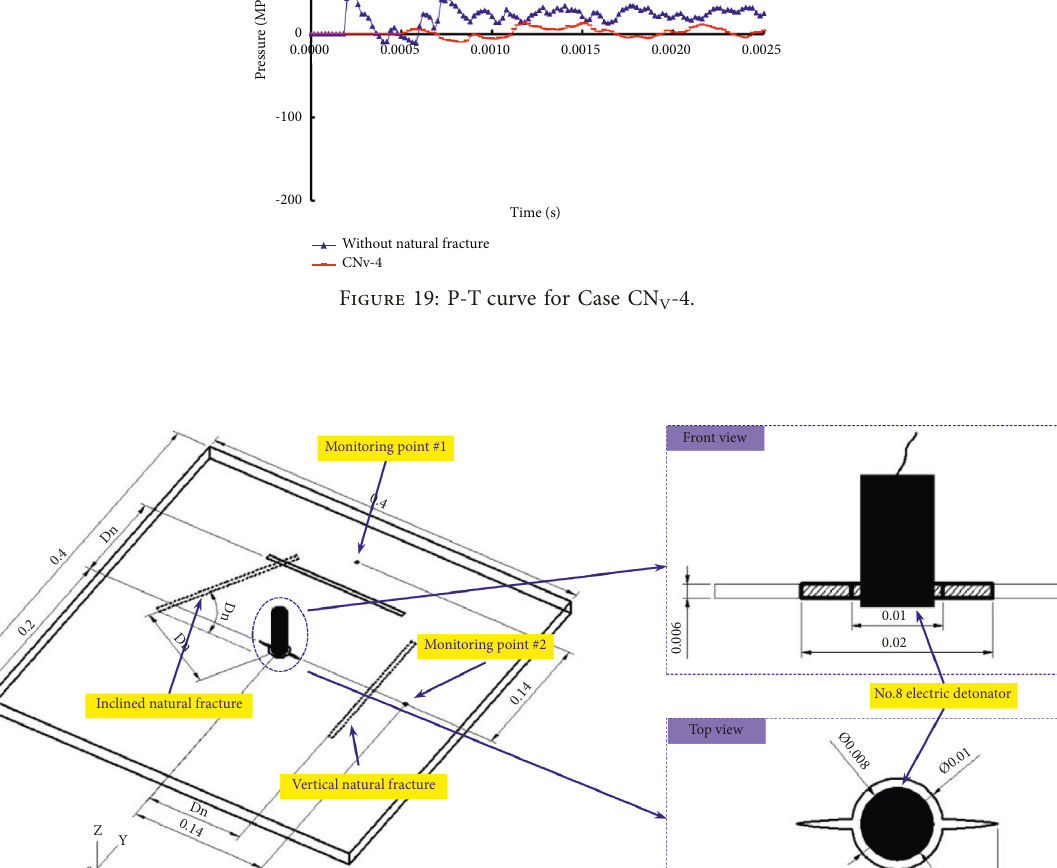
Figure 20: Structure diagram of test